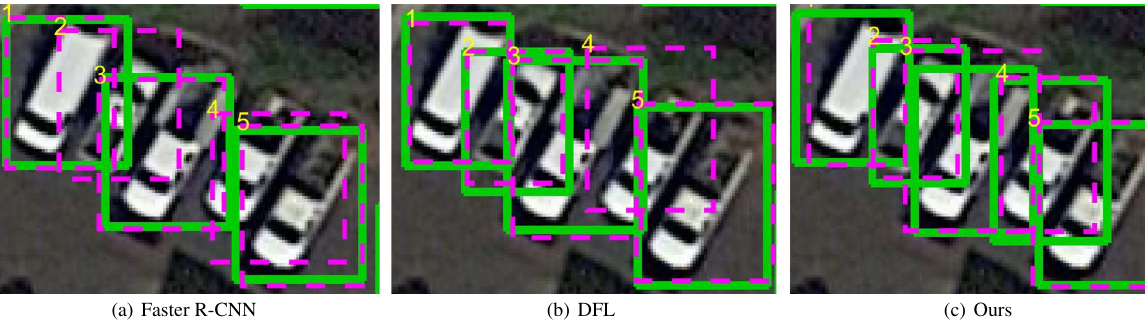
Figure 8. Example images showing the differences between the bounding box predicted by RPN (dashed purple box) and the finally predicted location (solid green box) regressed by the classification layer.